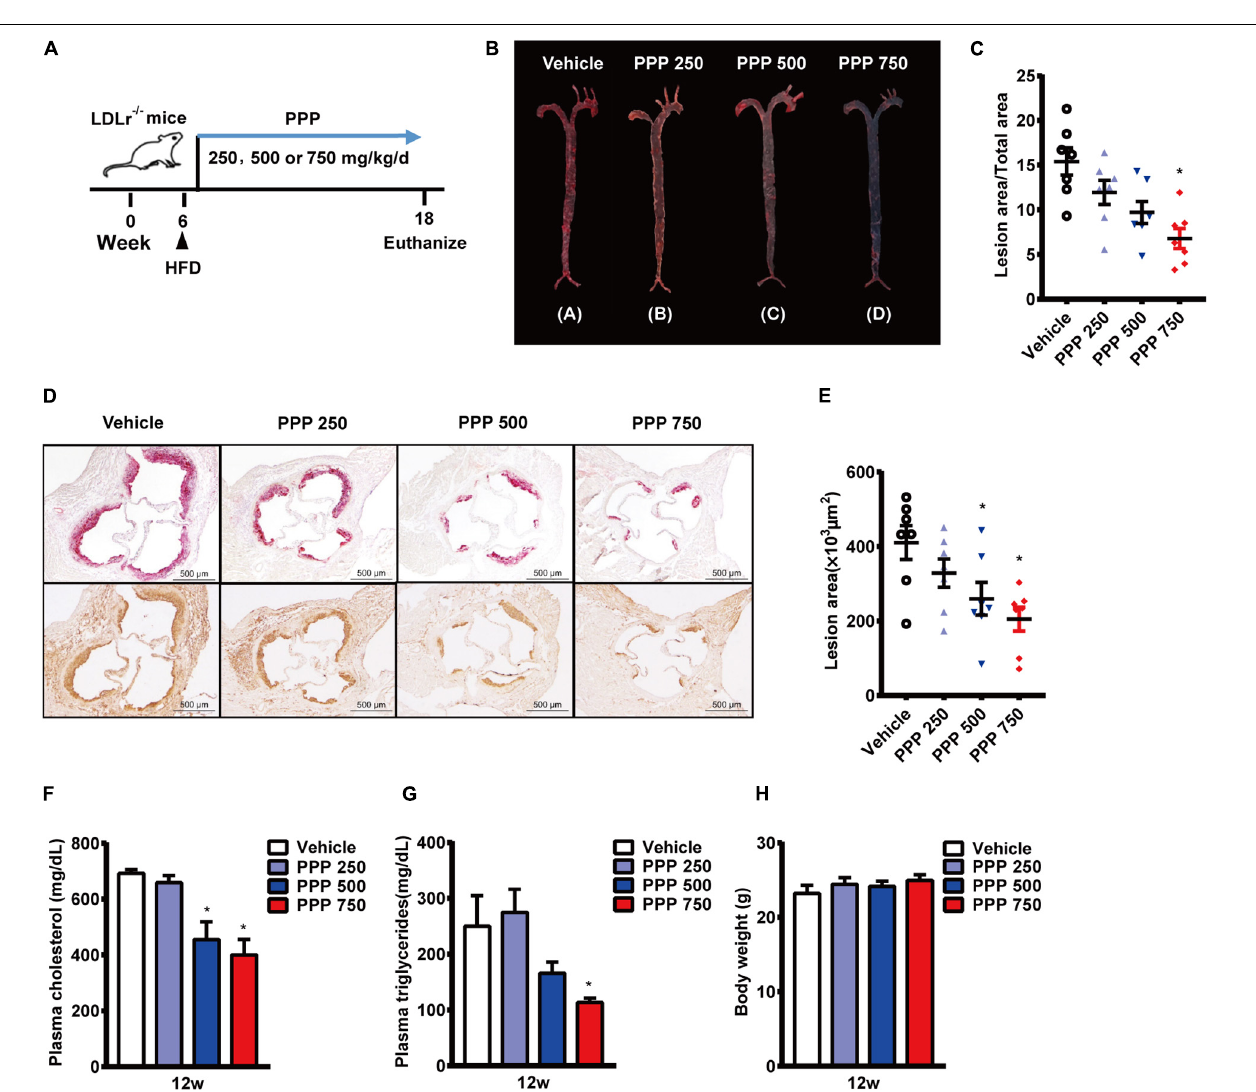
FIGURE 1 | Anti-atherogenic effects of PPP on LDLR − / − mice fed with HFD. (A) Schematic diagram of the experiments; (B,C) representative images of Oil Red O staining of mouse aortas (B) and quantitative results (C) ; (D,E) representative images of Oil red O staining of mouse aortic outflow tract (upper) and immunostaining of Mac-2 (bottom); (F,G) plasma TC (F) and TG (G) levels after 12-week HFD feeding; (H) Body weights of the mice. PPP 250, PPP 500, and PPP 750 represent PPP at the doses of 250, 500, and 750 mg/kg/day, respectively, including n = 6 biological replicates. * P < 0.05 vs. Vehicle.